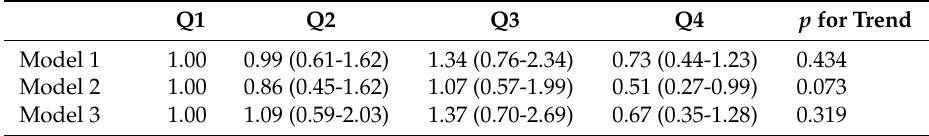
Table 2. Association between quartiles of handgrip strength and poor glycaemic control ( n = 1058).